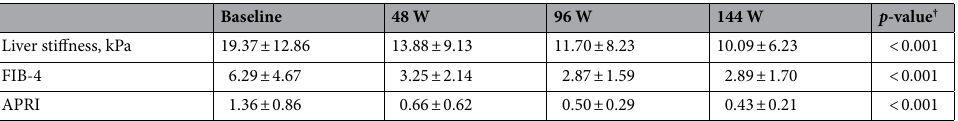
Table 2. Changes in liver fibrosis markers after DAA treatment. † K-paired sample Friedman tests were used as